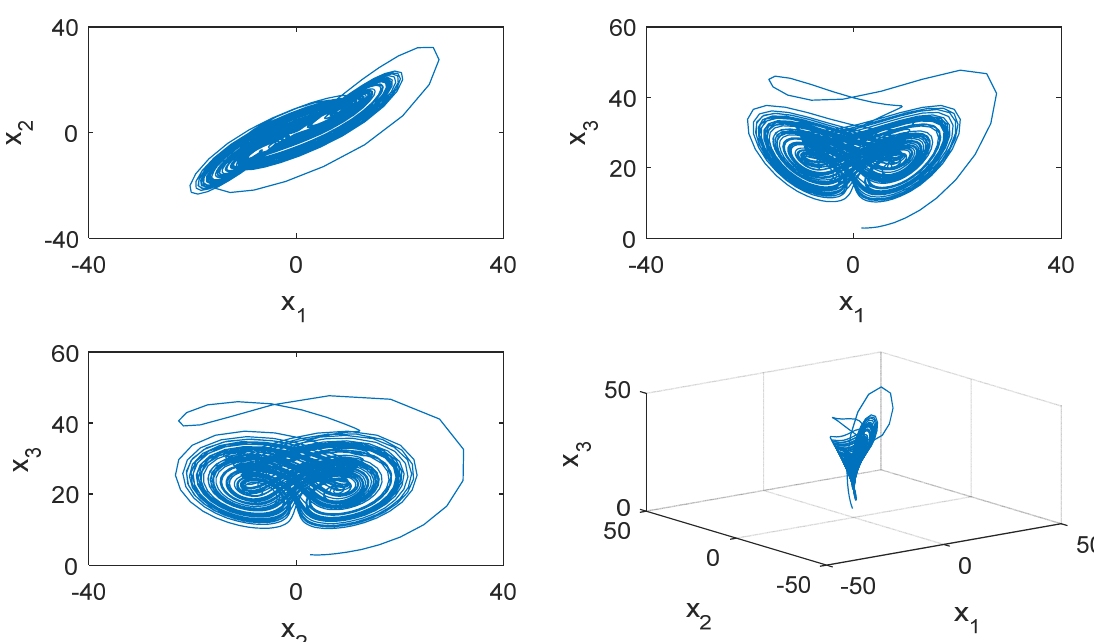
Figure 1. The chaotic behavior of a fractional-order Chen chaos system.